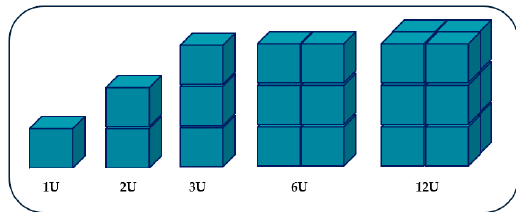
Figure 1. Standard CubeSat Sizes (1U-12U).